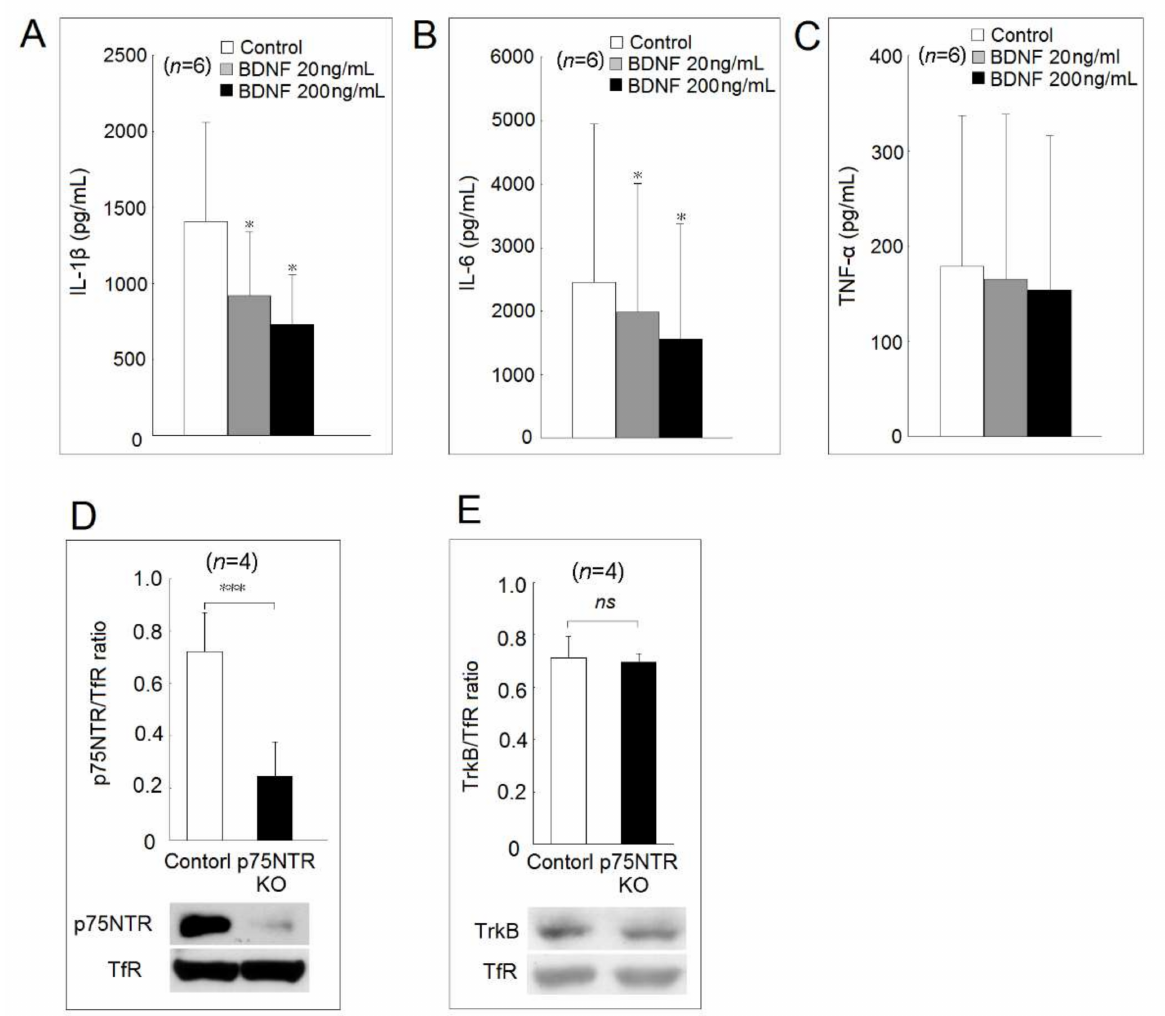
Figure 4. Effects of different concentrations of BDNF on ( A ) IL-1 β , ( B ) IL-6, and ( C ) TNF- α secretion in human monocyte-derived macrophages. U937 cells were transfected with CRISPR-Cas9 plasmid containing gRNA that targets p75NTR or control CRISPR-Cas9 plasmid as the control group. The cell surface expression ( D ) p75NTR and ( E ) TrkB on U937 cells were analyzed by Western blot analysis (ns, not significant; * p < 0.05; *** p <